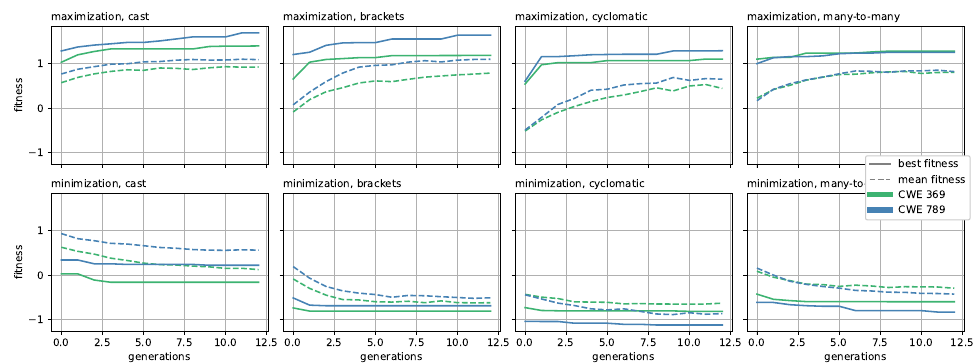
Figure 7. Fitness obtained when generating input instances with DSGE, maximizing or minimizing the considered concepts. Notice that, in the minimization experiments, the grammar is modified in order to include a vulnerability, while the ground truth of the individual evolved when maximizing the fitness is assumed to be